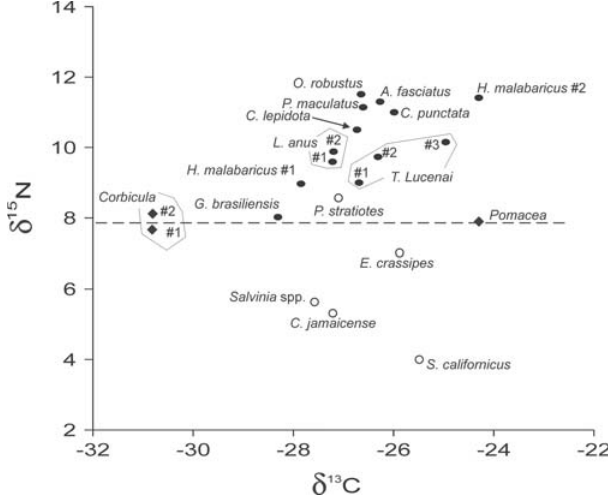
Fig. 2. Plot of δ 15 N and δ 13 C values for plants ( ), mollusks ) and fishes ( ) collected at Nicola Lake, Taim Hydrologi- cal System. Sources of carbon assimilated by consumers are indicated by the relative positions of taxa on the x-axis; trophic level is indicated by relative position on the y-axis. The dashed line distinguishes between producers and consumers. # sym- bols denotes different individuals of the same species.